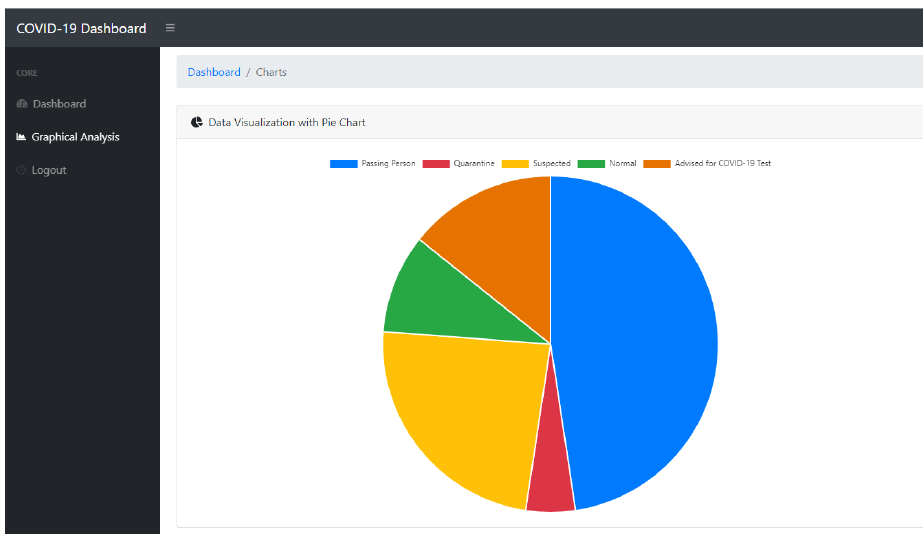
Figure 23. Database view of stored data.